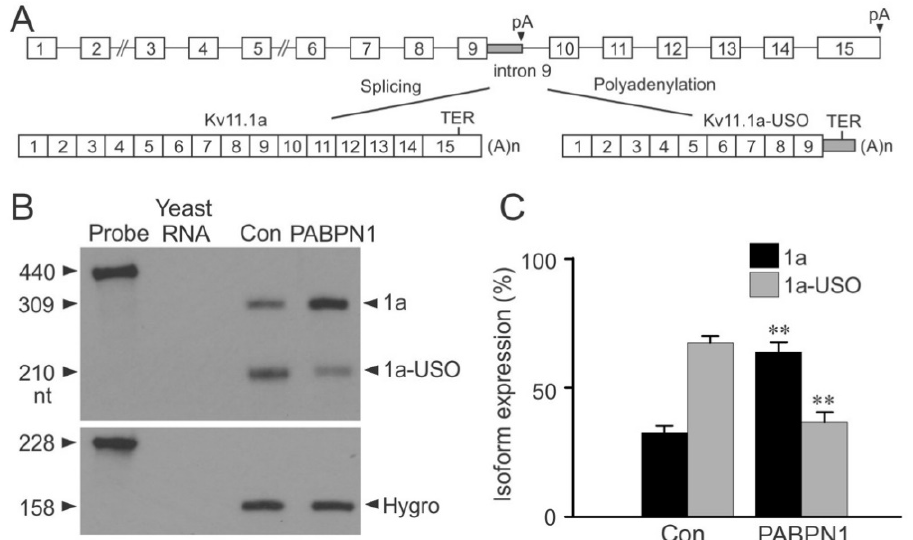
Figure 4. Regulation of Kv11.1 isoform expression by PABPN1. ( A ) Diagram of the short KCNH2 gene construct and the generation of the Kv11.1 C-terminal isoforms. ( B ) RPA analysis of mRNA from Flp-In HEK293 cells stably expressing the short KCNH2 gene following transfection with vector control or PABPN1. Yeast RNA was used as a control for the complete digestion of the probes by RNase. ( C ) The RPA signals were quantified, normalized to the expression of the hygromycin B resistance gene (Hygro) and plotted as the relative expression of the total isoform (Kv11.1a + Kv11.1a-USO) expression. Co-transfection with PAPBN1 significantly increased the relative expression of Kv11.1a transcripts (black bars) and significantly decreased expression of Kv11.1a-USO transcripts (gray bars) compared with vector-transfected control (**, p < 0.01, n = 3, error bars, mean ±